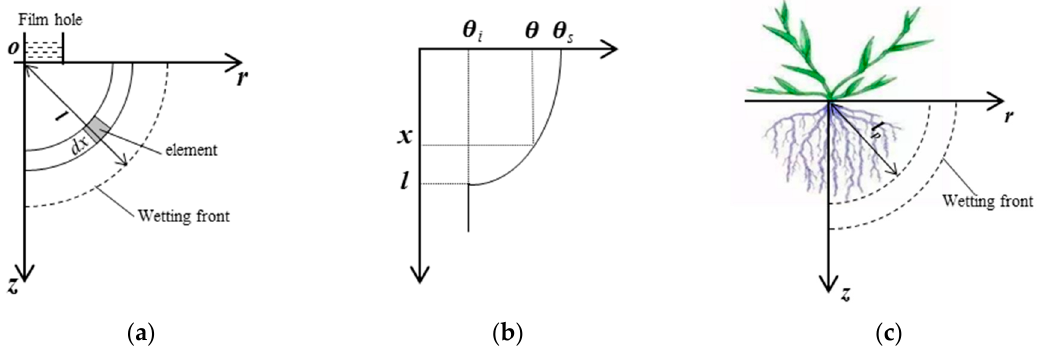
Figure 8. ( a ) Film hole irrigation profile; ( b ) Water content distribution curve of wetting body radius; ( c ) Root distribution of crops.